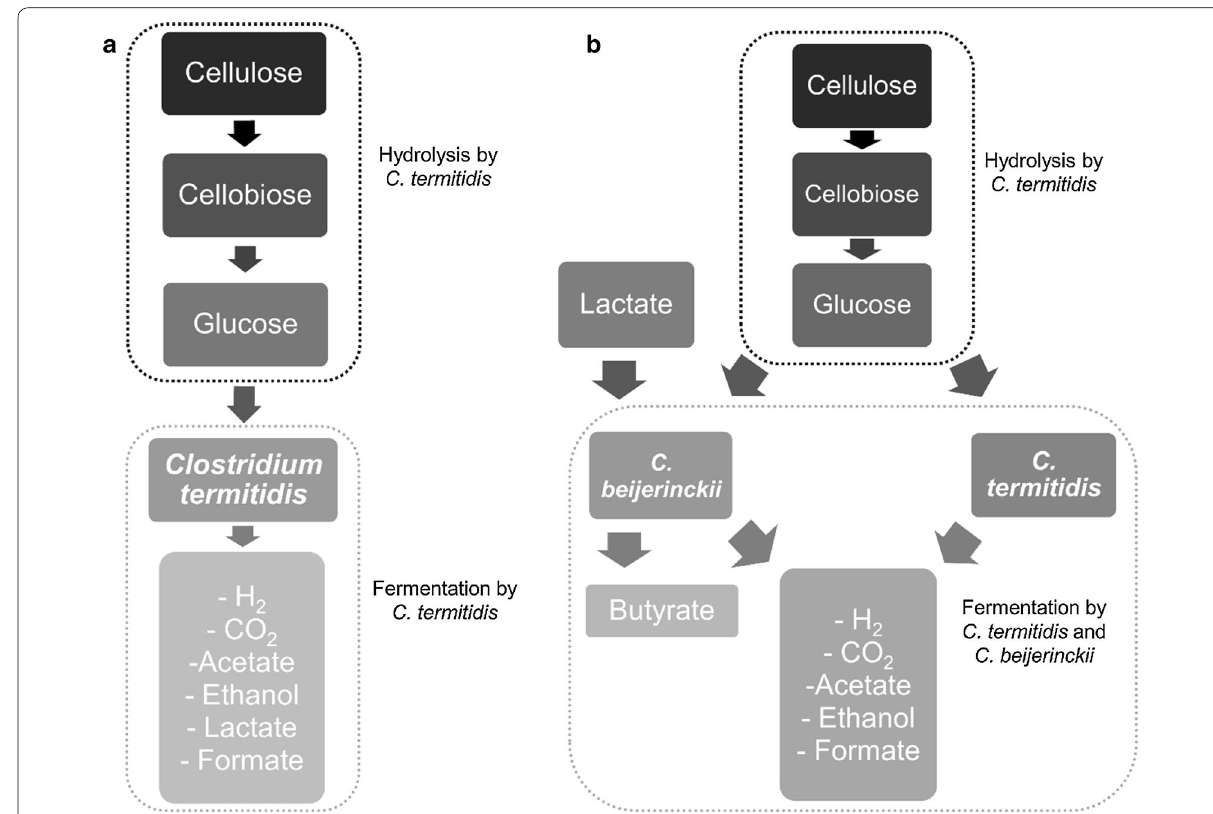
Fig. 1 Schematic representation of the steps involved in cellulose fermentation in a mono‑culture and b